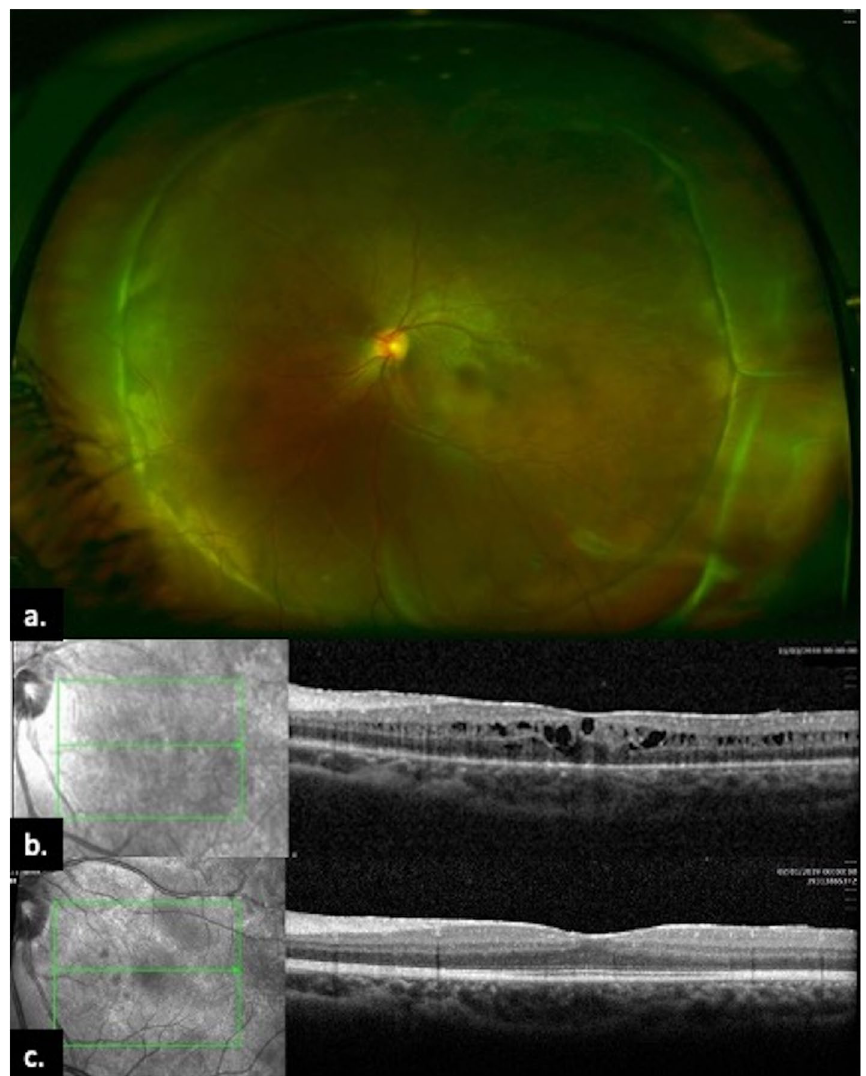
Fig. 2 a One year After surgical intervention flat retina with good 360° scleral indentation, b three weeks after surgery shows marked resolution of intra- and subretinal fluid and resolution of macular detachment, c two years after surgery shows normal looking foveal